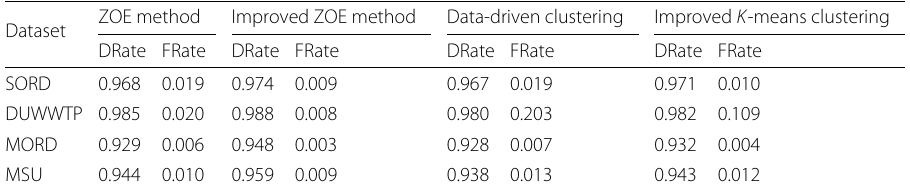
Table 3 Comparison of detection